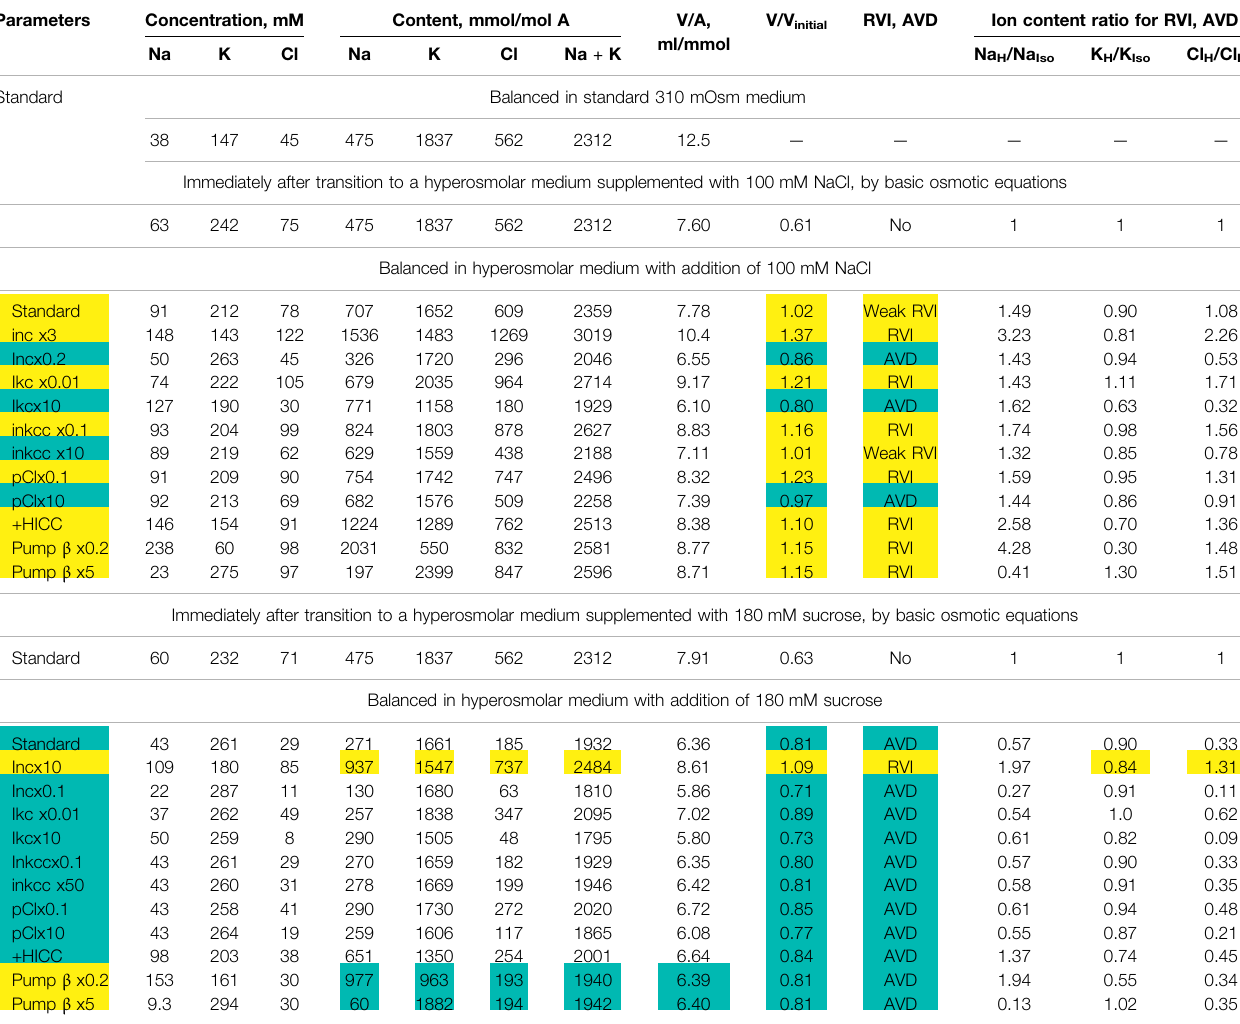
TABLE 5 | Dependence of RVI and AVD in the U937 cell model on the rate coef fi cients inc , ikc , inkcc , pCl, the permeability coef fi cient of the HICC channel ( pNa + pK ), and pump rate coef fi cient β changing simultaneously with an increase in external osmolarity. Other parameters remain unchanged. The calculation was carried out for a model with all cotransporters. hp (cid:1) 240 in all cases except hp (cid:1) 800 for Pump β . The RVI effect is marked in yellow, the AVD effect is marked in